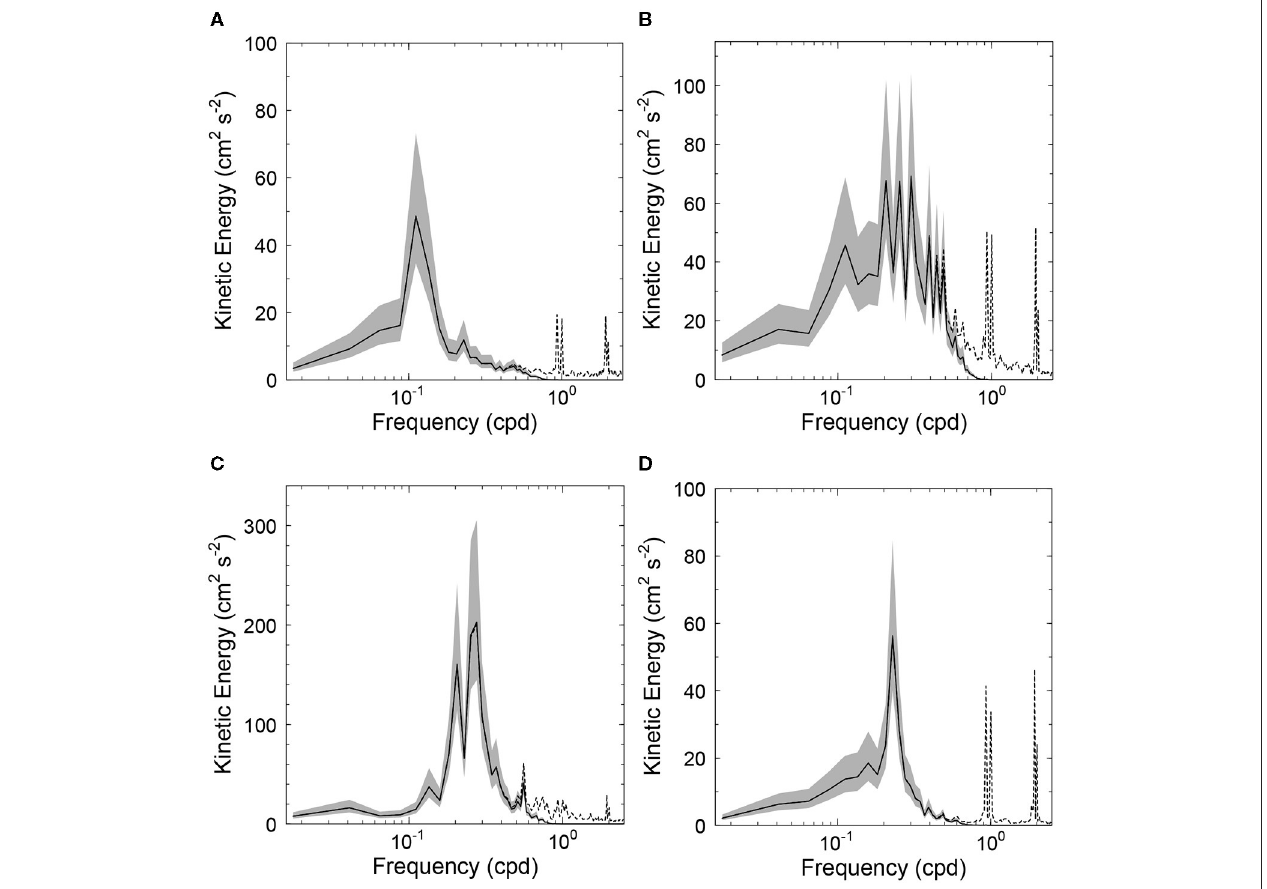
FIGURE 12 | The variance-preserving spectrum of the kinetic energy obtained by the deepest current meter (CM) at moorings (A) M1, (B) M2, (C) M3, and (D) M4. The solid and dashed lines indicate the power spectrum calculated from the filtered and unfiltered velocities, respectively. The 95% confidence limit of the former is shaded. Note that the vertical scale is different in each